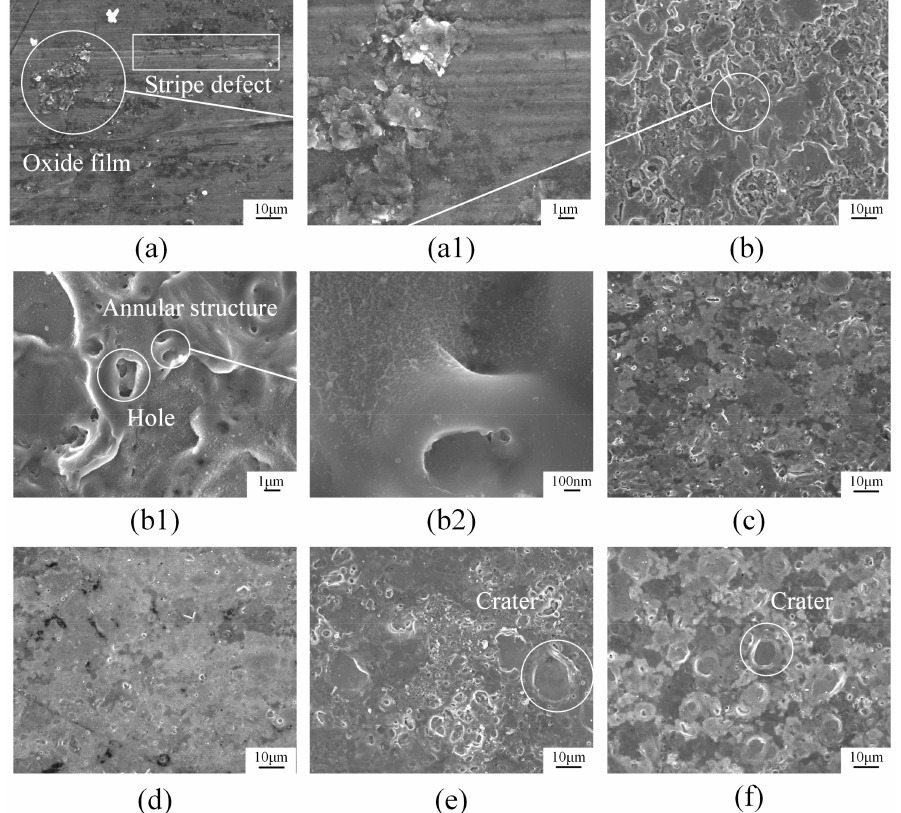
Figure 6. SEM microstructure of aluminum alloy after cleaning under di ff erent powers: ( a ) Reference sample; ( b ) 50 W; ( c ) 88 W; ( d ) 98 W; ( e ) 104 W; ( f ) 110